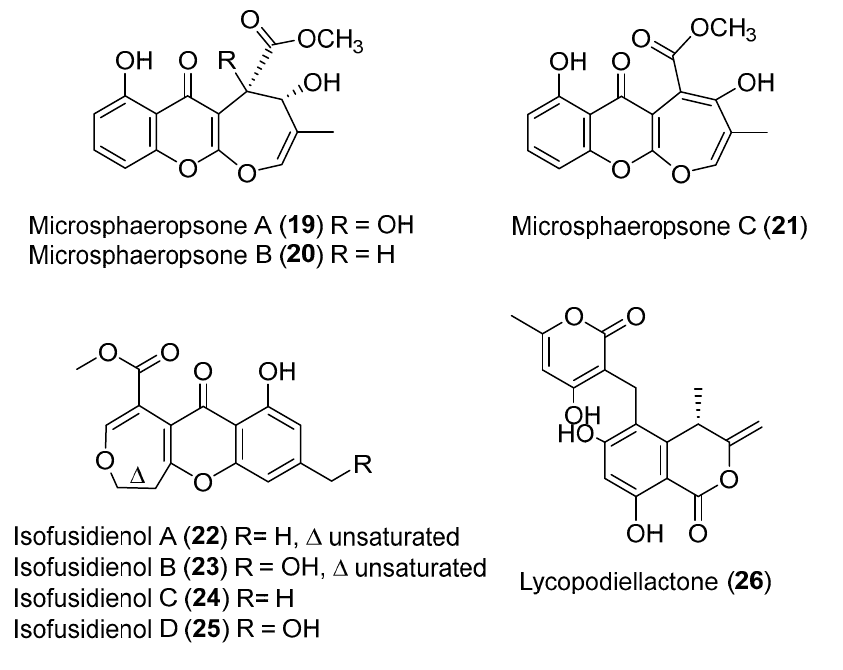
Figure 4. Structures of microsphaeropsones A–C ( 19 – 21 ), isofusidienols A–D ( 22 – 25 ) and lycopodiellactone ( 26